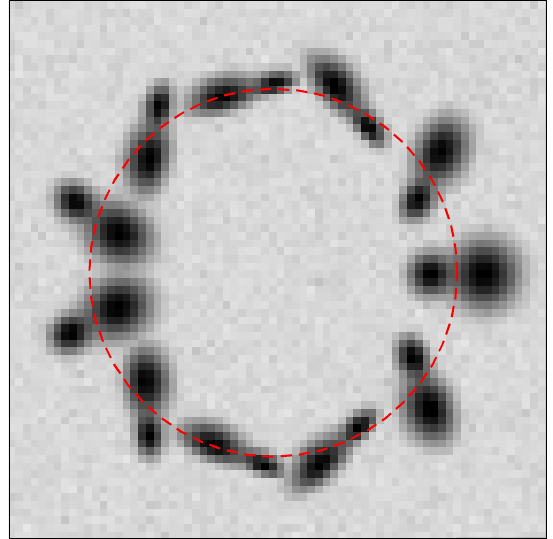
=6 pixels at 11 different 0